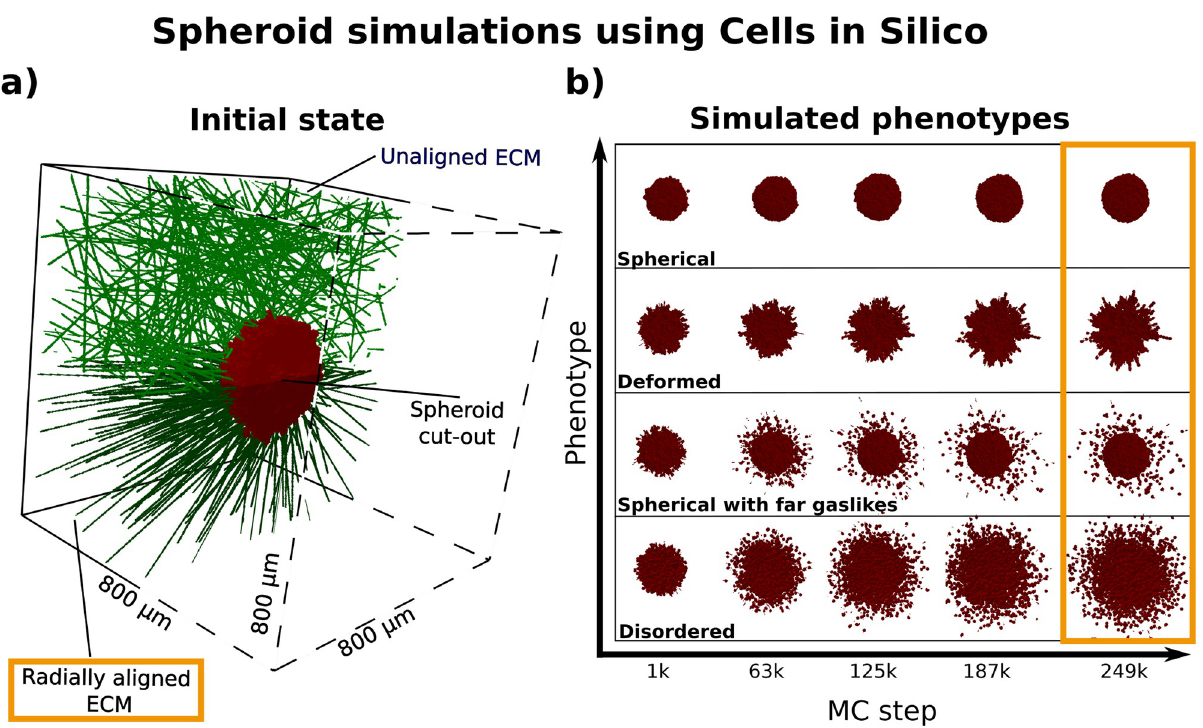
Fig 1. Simulated spheroids and emerging phenotypes. a) Cut-outs of the initial states of simulated spheroids for two ECM alignments. Each spheroid, shown in red and containing roughly 2000 cells, was placed into an (800 μ m) 3 volume and surrounded by either an unaligned or radially aligned ECM (green fibers). To improve visibility, the front half of the volume (dashed lines) is not shown b) Time evolution of simulated spheroids displaying four different phenotypes: “spherical”, “deformed”, “spherical with far gaslikes”, “disordered”. The ECM is radially aligned for these phenotypes, and is not shown in order to highlight the spheroid morphology. Each phenotype resulted from different combinations of parameters connected to the cell motility, the cell-cell adhesion and the interaction with the ECM (see Section 2.1 and Table 1). Each simulation lasted 250 000 Monte-Carlo (MC) steps, and shown are five snapshots for each simulation. A single MC step corresponds to roughly 1 s of real time in the context of this study. Throughout our investigation, we focused on the final configuration (orange rectangle), and used five replicates from each phenotype.